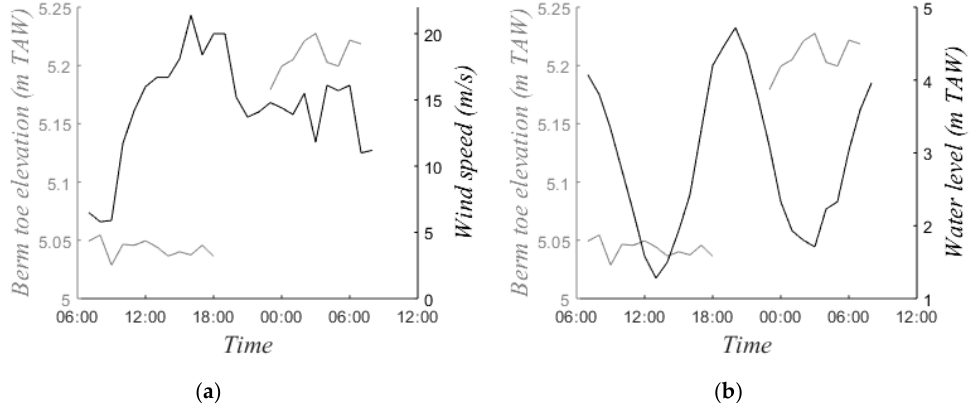
Figure 14. (a) Hourly elevation of the toe of the berm (average of the five cross-shore profiles) compared to the wind speed and (b) compared to the water level on 12/13 November.